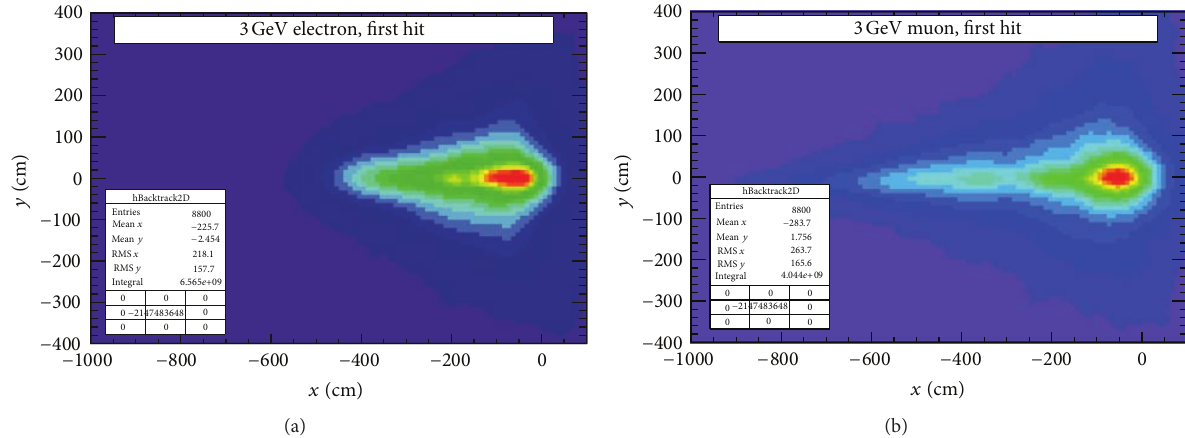
Figure28:Visualizationofthetrackingforelectron(a)andmuon(b)eventsinLENA.Thepicturesshowdensityprofilesforthelightemission inside the scintillator. Due to the broader and shorter profile of the emerging electromagnetic shower, 𝑒 and 𝜇 can be clearly distinguished [70].